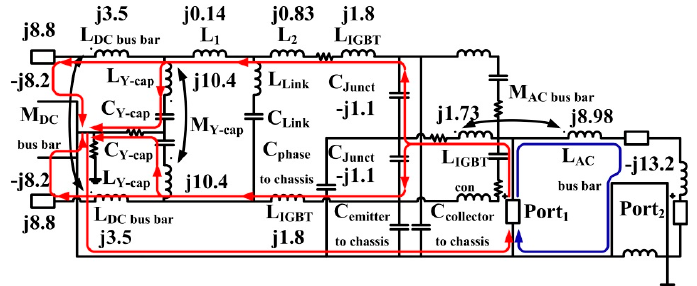
Figure 7. Current ‐ following path at 11 MHz.